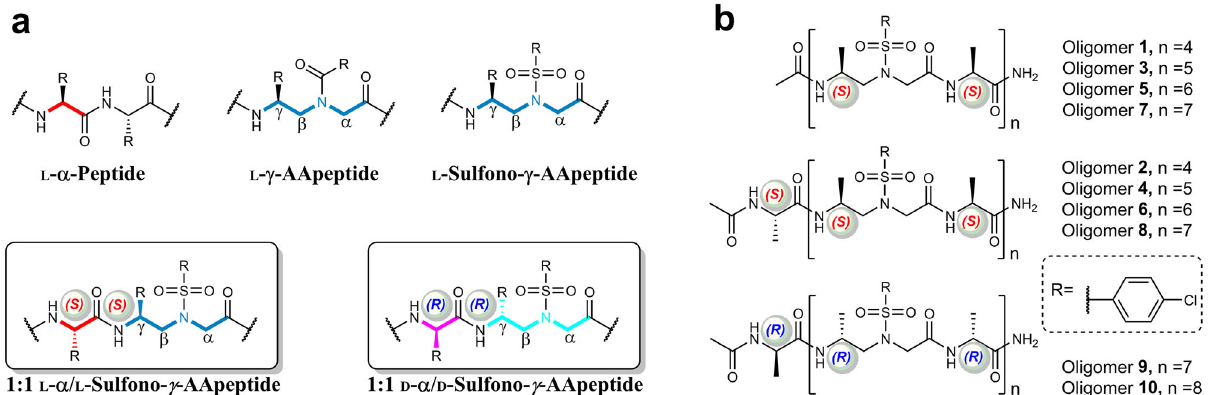
Fig. 1 Chemical structures of oligomers. a General structures of L - α -peptides, L - γ -AApeptides, L -sulfono- γ -AApeptides, 1:1 L - α / L -sulfono- γ -AApeptides, and 1:1 D - α / D -sulfono- γ -AApeptides. b 1:1 oligomer evaluated in the current study, both the exact ratio of 1:1 ( 1 , 3 , 5 , and 7 ) and 1: 1 + α ( 2 , 4 , 6 , 8 , 9 , and 10 ) types of oligomers were